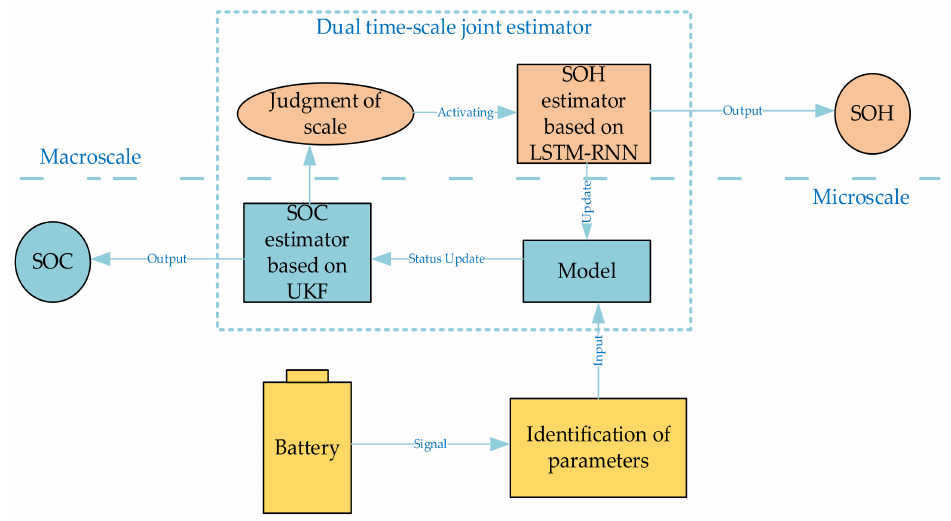
Figure 15. Flow chart for joint estimation of dual time